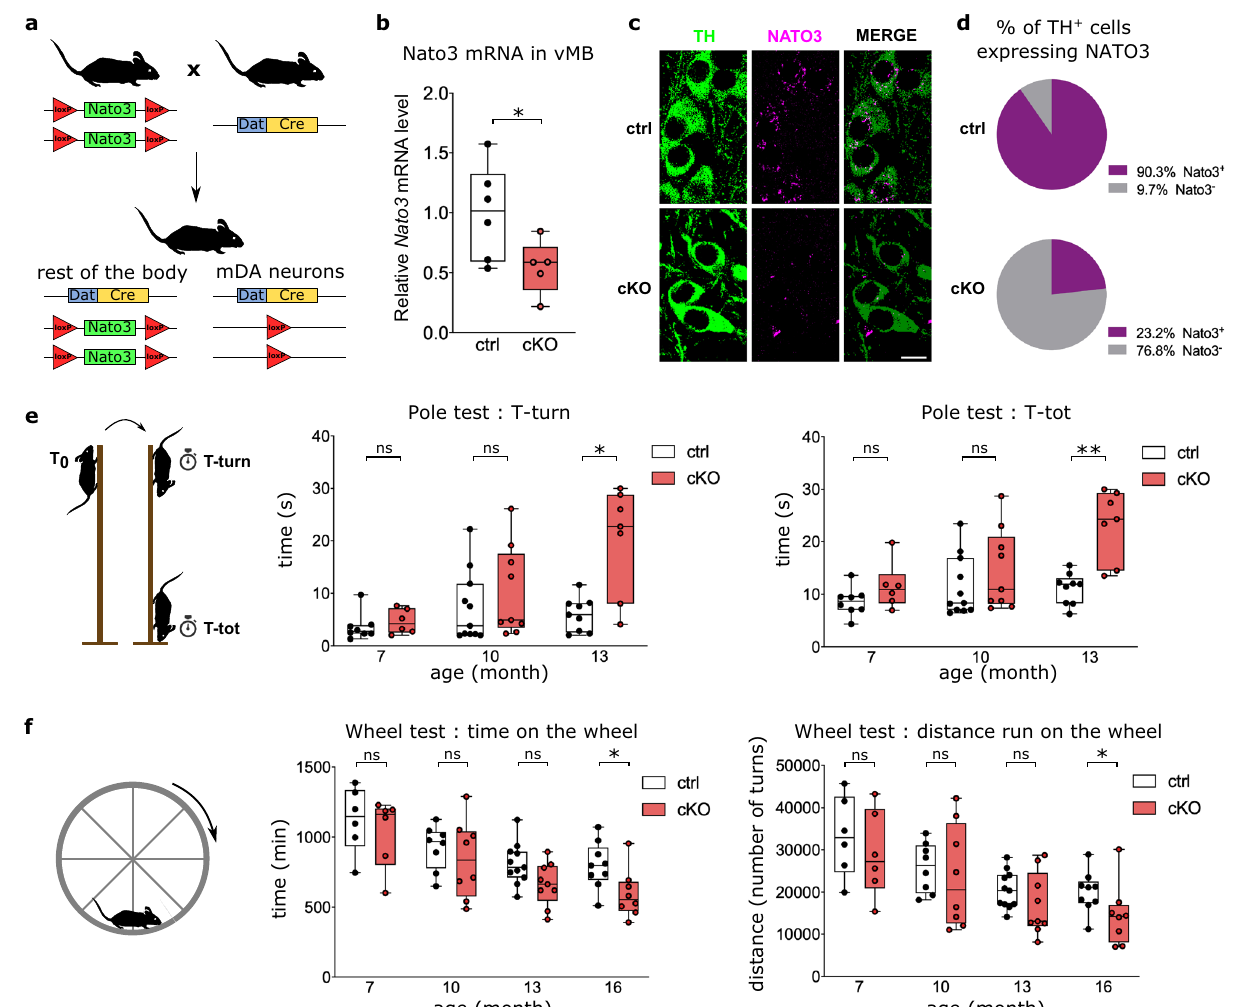
Fig. 6 Nato3 cKO in DA neurons leads to age-dependent impairment in locomotor coordination and activity. a Strategy for conditional ablation of Nato3 in differentiated DA neurons. b RT-qPCR analysis of Nato3 mRNA levels in ventral midbrains of 2-month-old Nato3 fl oxed (ctrl) and Nato3 DAT-Cre (cKO) mice. Data are represented as fold change relative to the average expression level in the ctrl. n = 5 (ctrl) and n = 6 (cKO) mice. Two-tailed Mann – Whitney test, * p = 0.0491. c Representative images of Nato3 (magenta) in situ hybridization of ventral midbrain coronal sections from 4-month-old control and Nato3 cKO mice. mDA neurons were detected by anti-TH antibodies (green). Scale bar, 10 μ m. 3 sections from 2 mice per genotype were analyzed. d Quanti fi cation of the percentage of TH + mDA neurons expressing Nato3 from ( c ). More than 300 TH + neurons per genotype were analyzed. e Pole test. The time taken to orient downward (T-turn; left) and the total time to turn and descend the pole (T-tot; right) are shown. The numbers of animals tested were: n = 8 (ctrl, 7 months), n = 6 (cKO, 7 months), n = 11 (ctrl, 10 months), n = 9 (cKO, 10 months), n = 9 (ctrl, 10 months), n = 7 (cKO, 13 months). Two-tailed Mann – Whitney test comparing ctrl and cKO of the same age. T-turn at 13 months, * p = 0,0207. T-tot at 13 months, ** p = 0.0032. ns not signi fi cant. f Voluntary wheel running test. The time spent running on the wheel (left) and the total distance run (right) are shown. n = 6 animals (ctrl, 7 months), n = 6 (cKO, 7 months), n = 8 (ctrl, 10 months), n = 8 (cKO, 10 months), n = 11 (ctrl, 10 months), n = 9 (cKO, 13 months), n = 9 (ctrl, 16 months), n = 8 (cKO, 16 months). Two-tailed Mann – Whitney test comparing ctrl and cKO of the same age. Time at 16 months, * p = 0.0206. Distance at 16 months, * p = 0.0360. ns not signi fi cant. Box boundaries in ( a ), ( e ) and ( f ) are the 25th and 75th percentiles, the horizontal line across the box is the median, and the whiskers indicate the minimum and maximum dysmorphic (Fig. 8c bottom panels and 8d). Mitochondria from cKO mice (Fig. 8a, b), prior to the onset of locomotor dysfunction TH-negative cells appeared normal in aged Nato3 cKO mice, (13 months) (Fig. 6e, f), these results also suggest that mitochondrial suggesting that the age-dependent deterioration of mitochondrial abnormalities in the SN DA neurons are likely causally involved in morphology was cell-autonomously induced by Nato3 deletion in the locomotor de fi cits caused by Nato3 conditional ablation. DA neurons (Fig. 8c right bottom panel). Although mitochondrial Since Fer2 loss of function downregulates Sod2 mRNA levels and size did not differ between the two genotypes at both ages, SOD2 overexpression partially rescues the loss of PAM neurons in mitochondria in the SN neurons in aged Nato3 cKO mice were Fer2 2 Drosophila mutants (Fig. 4h), we wondered whether SOD2 is downregulated in Nato3 cKO mice. Anti-SOD2 immunostaining rounder than those in the control mice (Fig. 8e). These results indeed found a signi fi cant reduction in SOD2 levels in DA neurons demonstrate that Nato3 is required for the maintenance of in the VTA and SN of 11- and 16 – 18 months old Nato3 cKO mice mitochondrial integrity in the DA neurons of the SN during aging. compared with age-matched controls (Fig. 8f, g). However, Sod2 Since mitochondrial dysmorphism appeared at 11 months in Nato3